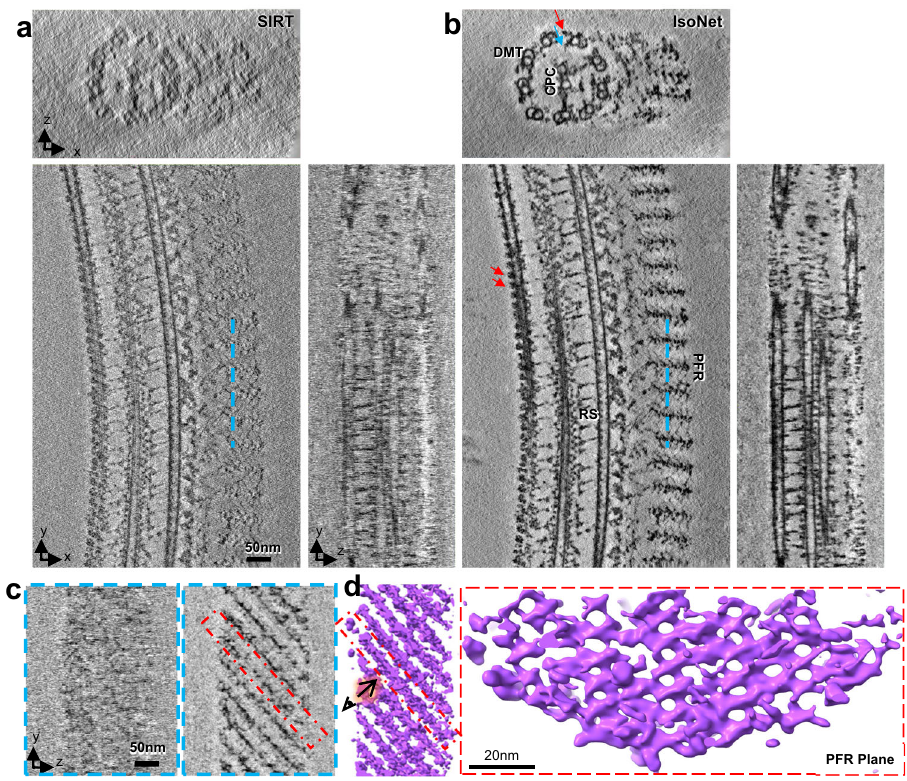
Fig. 4 | Architecture of the PFR revealed after missing-wedge correction. a , b Orthogonal slices of a tomogram of fl agellar for SIRT reconstruction ( a ) and IsoNet reconstruction ( b ). DMT doublet microtubule, CPC central-pair complex, RS radial spoke, Red arrows outer arm dyneins, Blue arrow inner arm dynein. c YZ